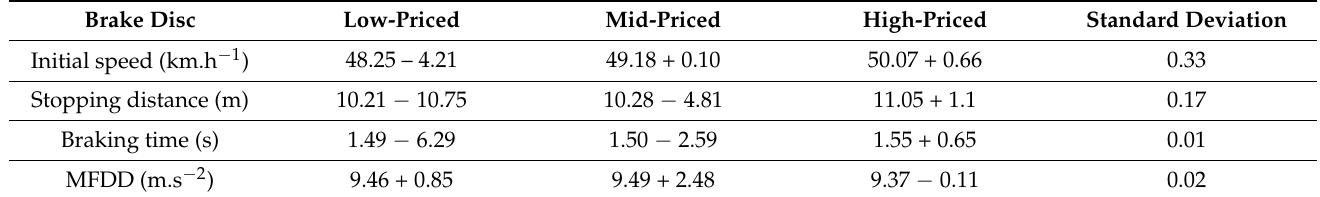
Table 12. Vehicle’s braking characteristics during the repeated